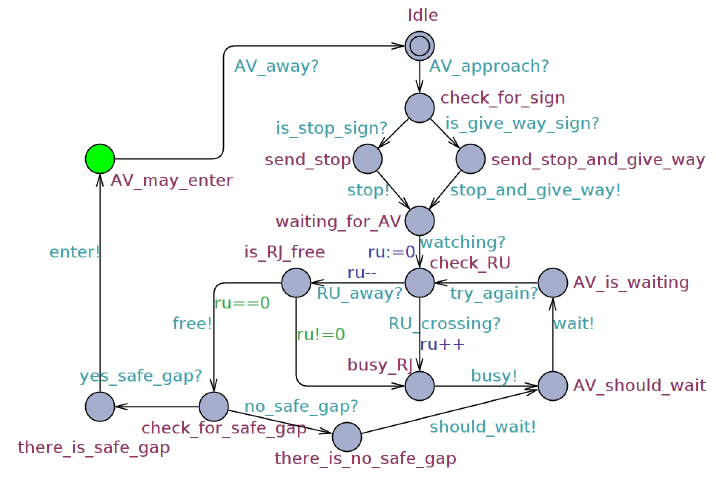
Figure 4. UPPAAL template for RJ_Env automaton.